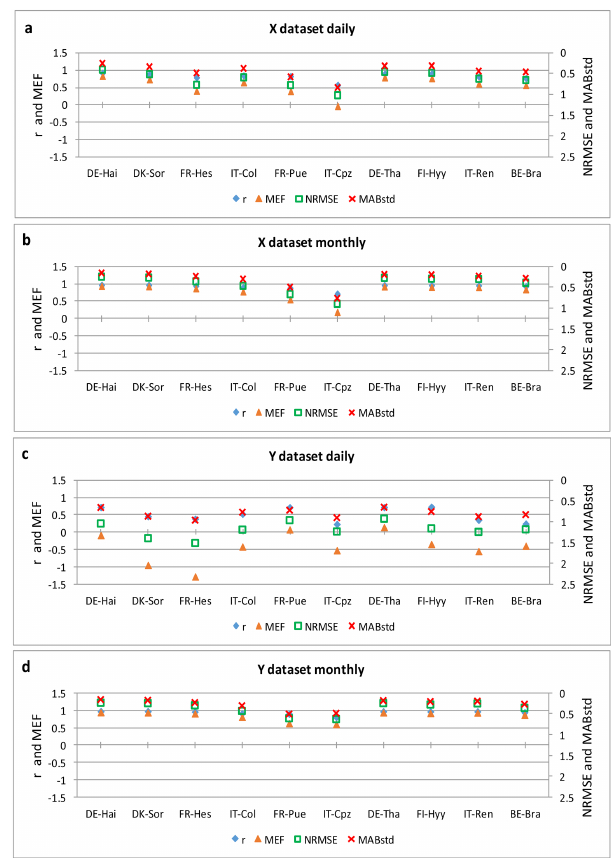
Figure 1. 3D-CMCC FEM performance indices at different timescales; daily (a) and daily aggregated to month (b) for X data set. (c) and (d) refer to Y daily and Y monthly data set following decomposition technique proposed in Zhao et al. (2012). DE-Tha refers to the 1S simulation, IT-Ren to the 2L_2C simulation, BE- Bra to the P_Q-3L simulation (see